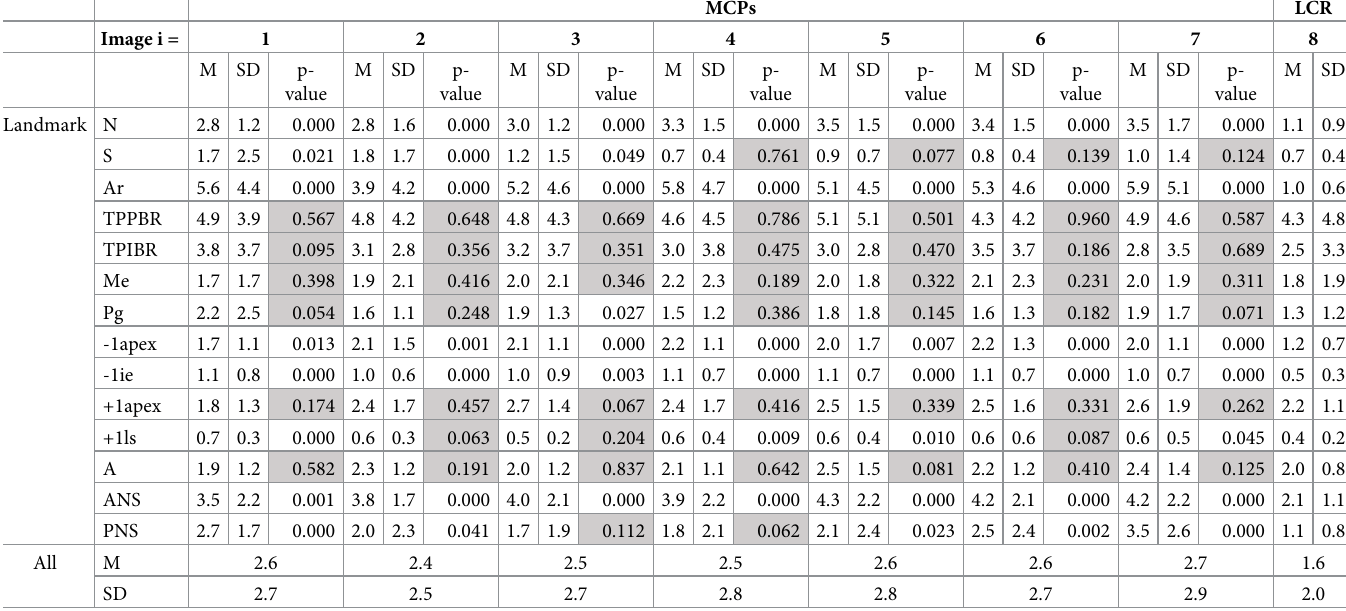
Table 4. Relative metric measurements. Mean (M) and standard deviation (SD) of relative distance values in mm (Eq 2) and corresponding p-values for each landmark population. Statistical equivalence was assumed for p-value > 0.05 (gray